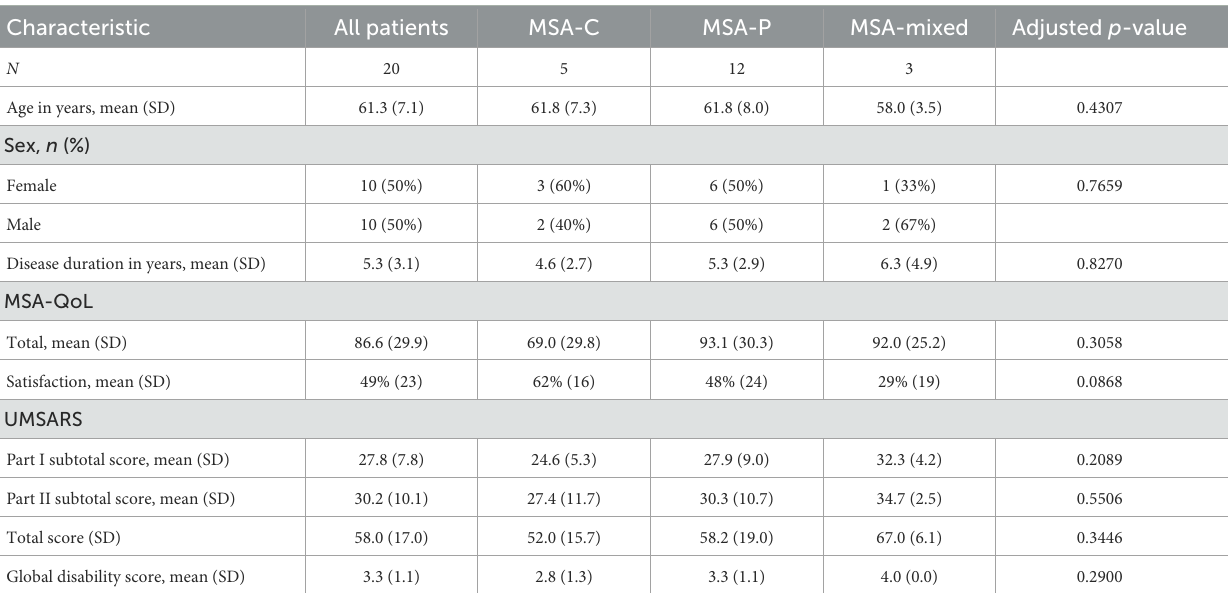
TABLE 1 Patient